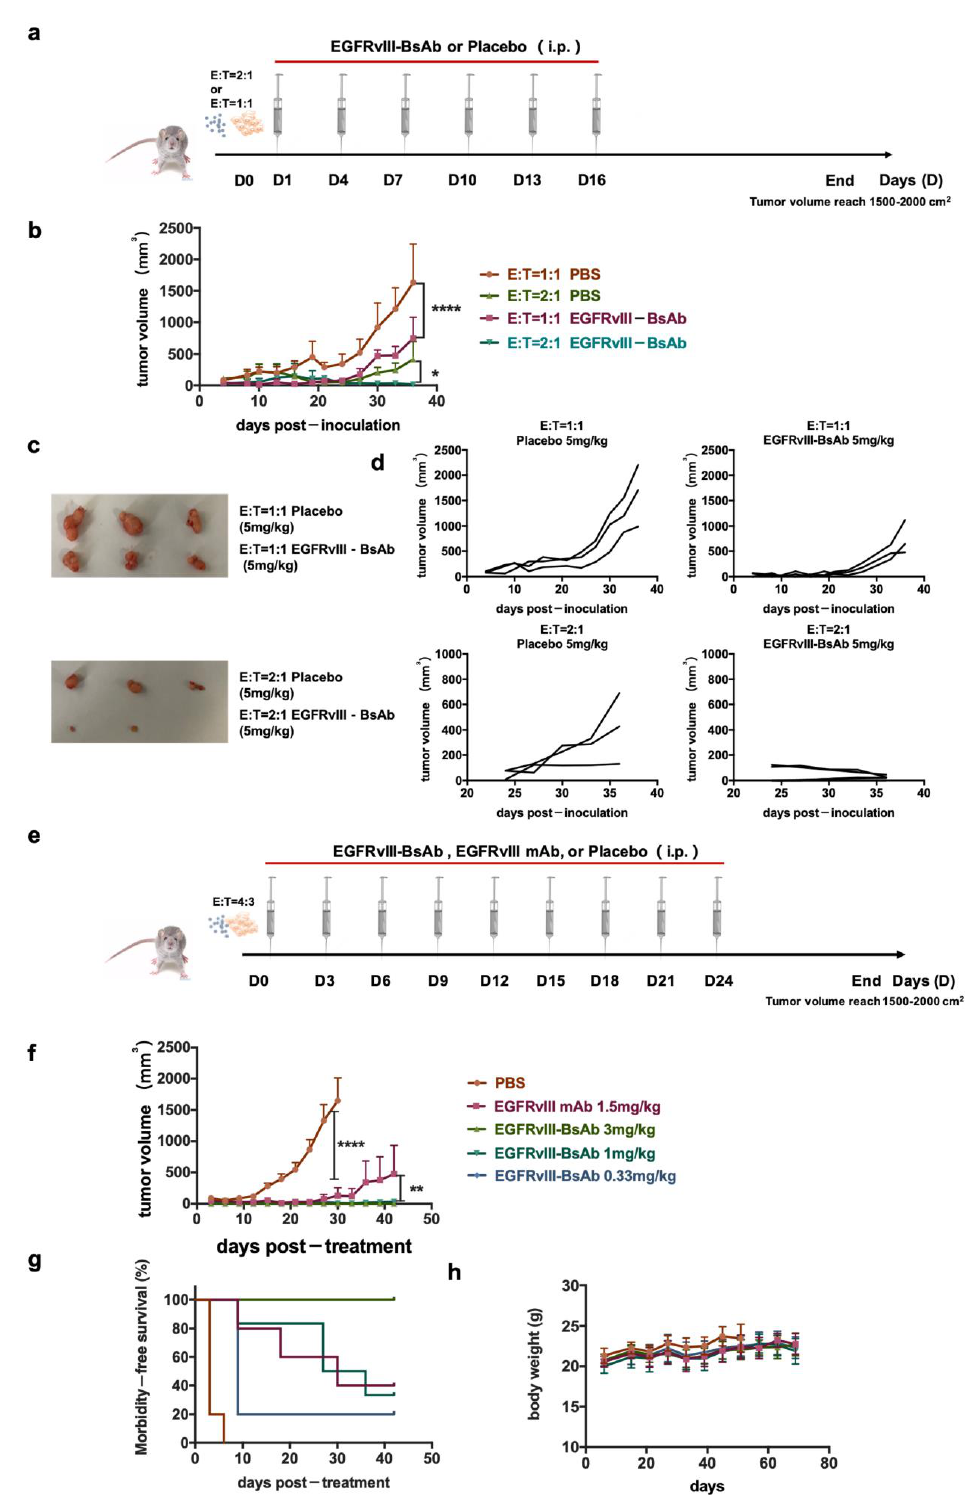
Figure 5. EGFRvIII-expression of tumor growth inhibition in vivo by EGFRvIII-BsAb. ( a ) Schematic schedule of tumor inoculation and treatment. ( b ) Time course of U87MG. ∆ EGFR tumor-growing. Data are presented as mean ± SEM ( p < 0.0332 (*), p < 0.0001 (****)). ( c ) Images of stripped tumors. ( d ) U87MG. ∆ EGFR tumor-growing time course under various E/T ratios. Data are presented as measured tumor volumes from individual mice. ( e ) Schematic schedule of tumor inoculation and treatment. ( f ) Tumor-growing time course( p < 0.0021 (**), p < 0.0001 (****)). ( g ) Morbidity time course. ( h ) Body-weight time